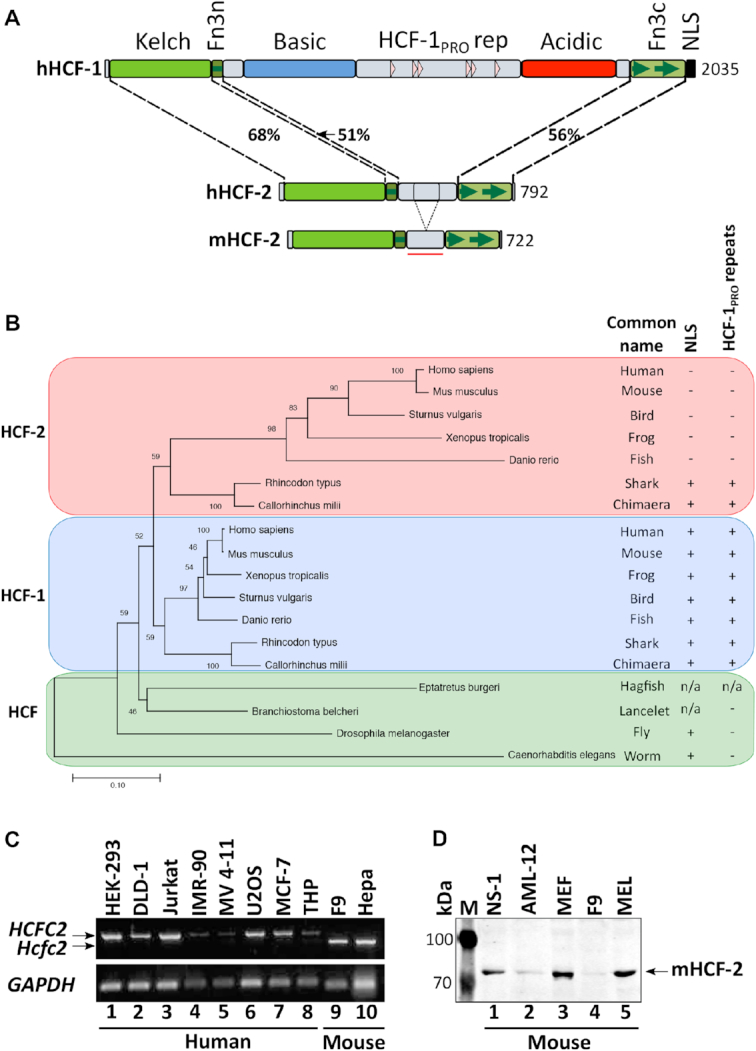
HCF-2 conservation in vertebrates and cognate gene expression in mammalian cells. (A) Diagrams of human HCF-1, and human and mouse HCF-2. Percentage identity between the human HCF-1 and HCF-2 Kelch, Fn3n and Fn3c segments is given; NLS, nuclear localization signal. The Fn3n-to-Fn3c linker region in mHCF-2 used for antibody generation is indicated with a red bar. (B) Evolutionary tree of HCF-protein Kelch domains from 11 animal species inferred using the Minimum Evolution method (25). The optimal tree with the sum of branch length = 2.66193529 is shown. The percentage of replicate trees in which the associated taxa clustered together in the bootstrap test (500 replicates) (29) are shown next to the branches. The tree is drawn to scale, with branch lengths in the same units as those of the evolutionary distances used to infer the phylogenetic tree. Common name of species, presence of NLS and HCF-1PRO repeats are shown separately. n/a, not available. (C) RT-PCR of HCFC2 in the indicated cell lines of human (lanes 1–8) and mouse (lanes 9–10) origin. (D) Immunoblot of the indicated mouse cell line extracts probed with α-HCF-2 antibody described in Supplementary Figure S1.